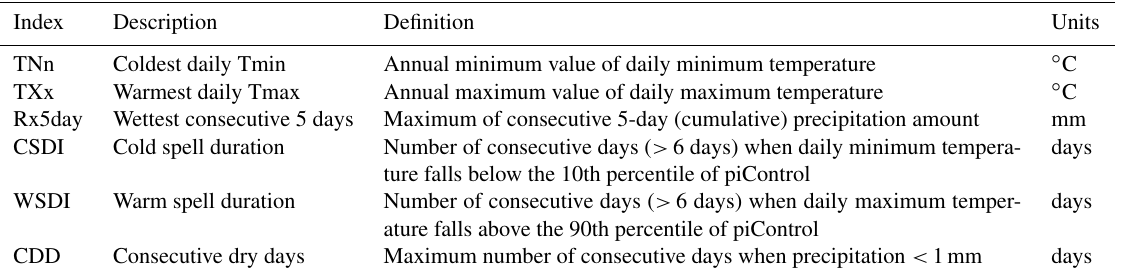
Table 2. Indices of climate